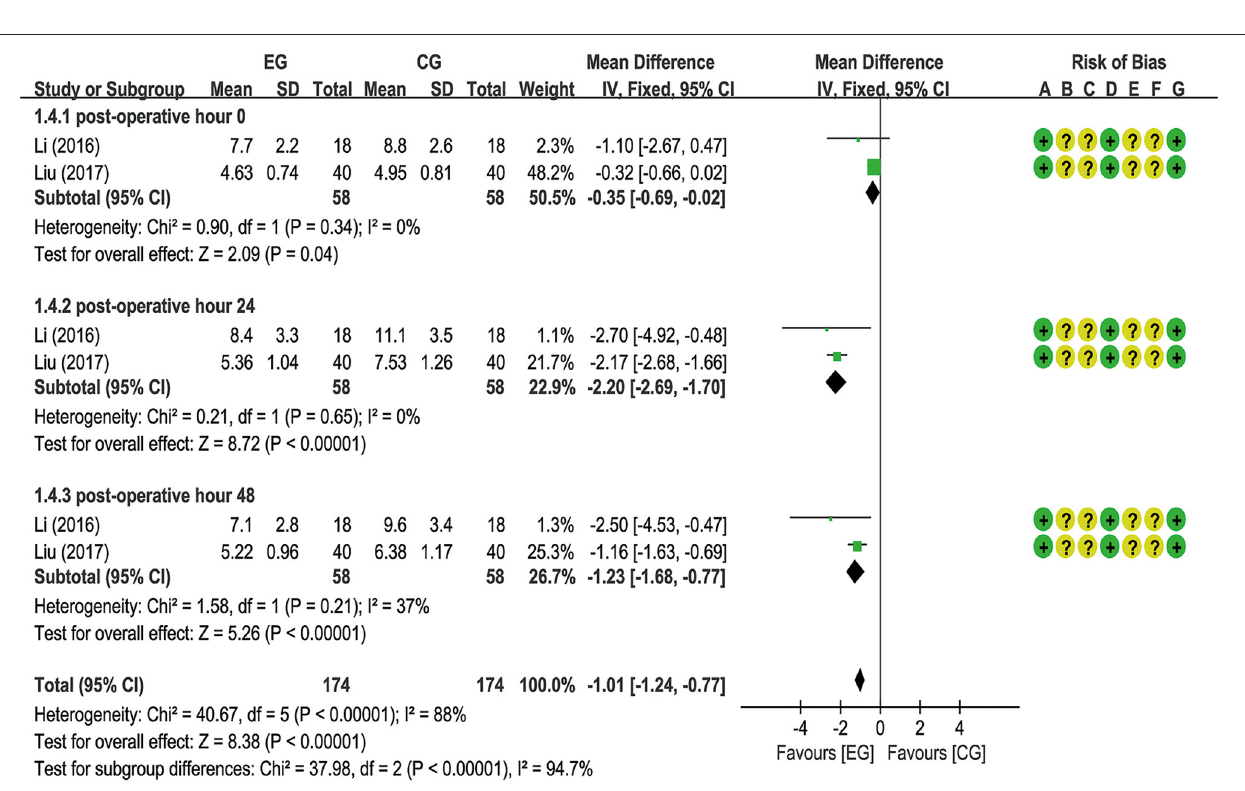
Frontiers in Medicine |